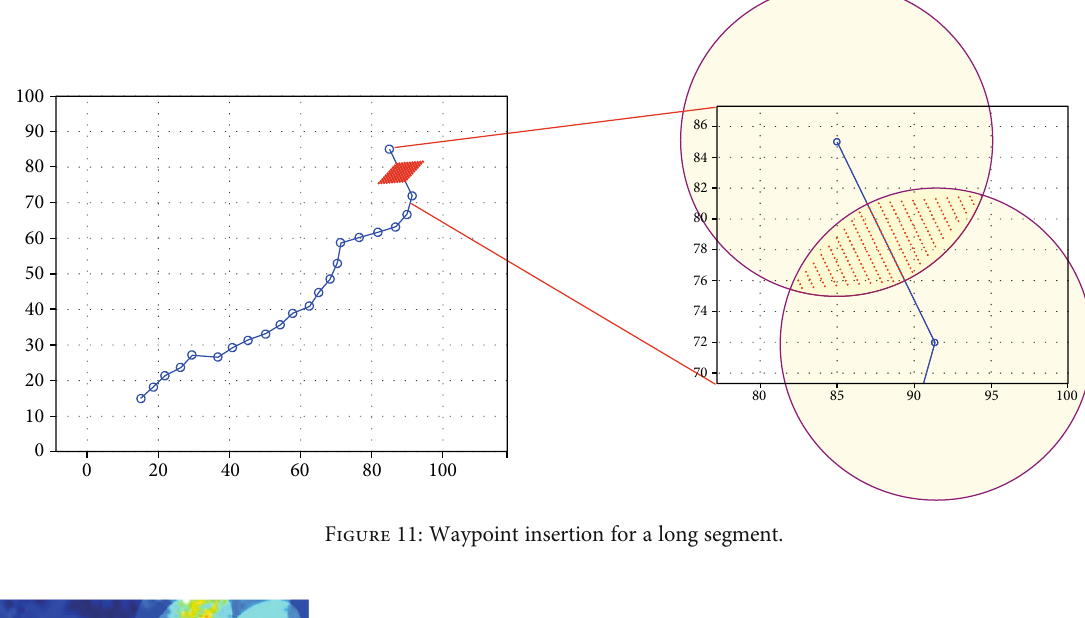
Figure 11: Waypoint insertion for a long segment.